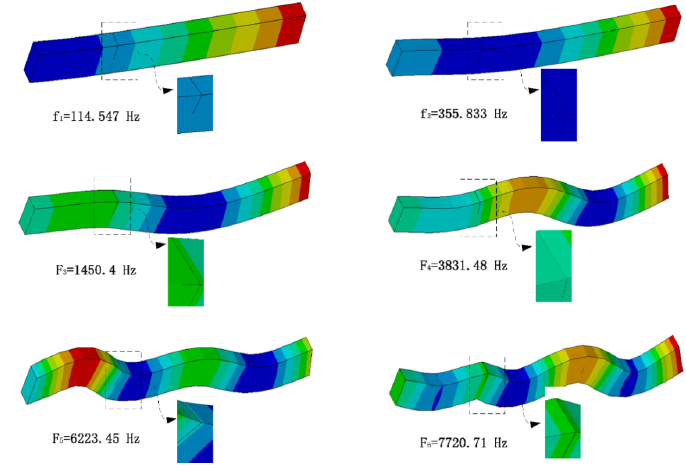
Figure 3. The first six modal frequencies and modes when p = 50% and q = 30%.